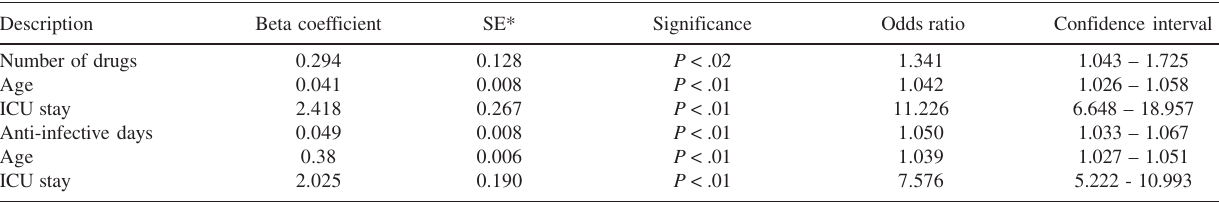
Table 4 - Logistic regression variables of hospital mortality (All patients, n= 3706) Description Beta coefficient SE* Significance Odds ratio Confidence